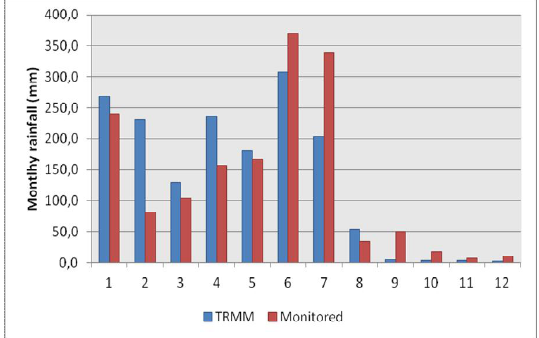
Figure 5. Monthly rainfall – TRMM x monitored data (year